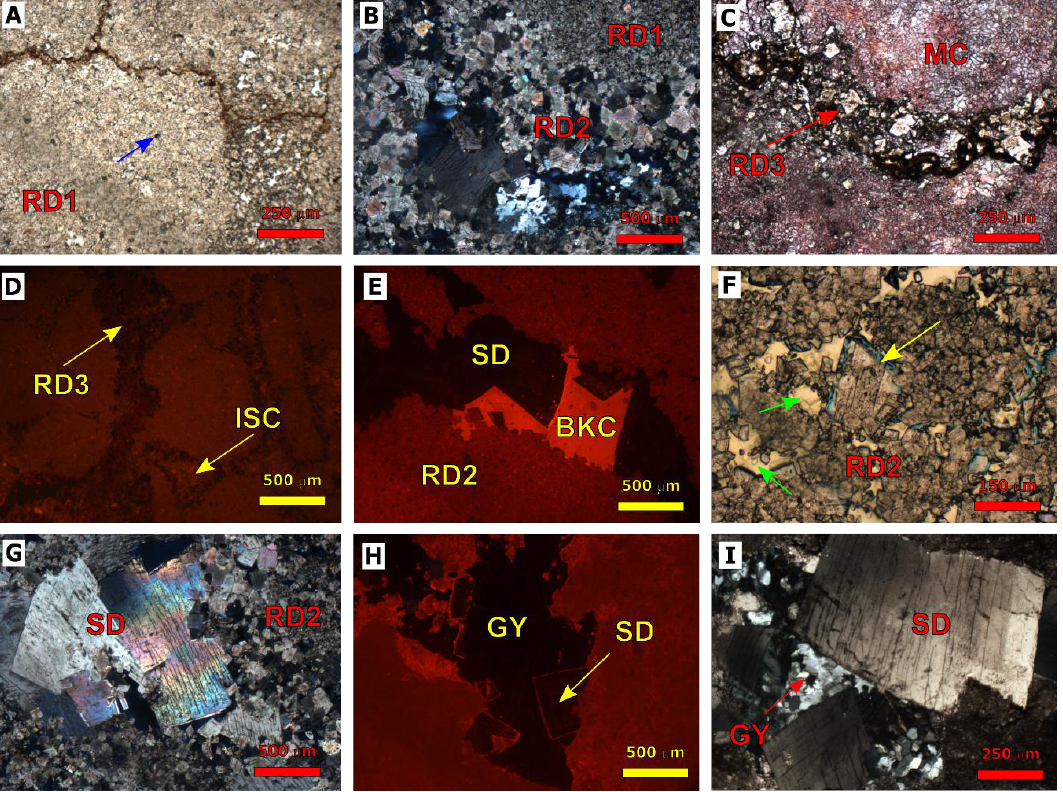
Figure 4. Dolomitization in Silurian formations. ( A ) Photomicrograph (PPL) of planar-s, pervasive replacive micro to fine crystalline dolomite matrix (RD1). Sample 1-18; Well: DGR1-CR65; depth: 176.13 m. The blue arrow indicates the presence of framboidal pyrite in the matrix; ( B ) photomicrograph (XPL) of non-planar, pervasive replacive micro to fine crystalline dolomite matrix and planar-e pervasive replacive medium crystalline dolomite matrix (RD2). Sample 1-31; Well: DGR1-CR133; depth: 440.92 m; ( C ) photomicrograph (PPL — after staining) of planar-e, selective replacive medium crystalline dolomite matrix (RD3) associated with dissolution seams showing cloudy cores and clear rims (red arrow). Undolomitized limestone matrix (MC) shows a pink color after staining. Sample 8-12; well: DGR8-CR137 (2); depth: 378.75 m; ( D ) CL photomicrograph of isopachous calcite cement (ISC) and selective replacive medium crystalline dolomite matrix (RD3) both showing dully-red luminescence. Note the change from dull to red luminescent of ISC towards the center of the vug. Sample 8-10; well: DGR8-CR122; depth: 332.26 m; ( E ) CL photomicrograph of bright luminescent blocky calcite cement (BKC) postdating non-luminescent saddle dolomite cement (SD) surrounded by dull-red medium crystalline dolomite matrix (RD2). Sample 8-13; Well: DGR8- CR139; Depth: 382.4 m; ( F ) photomicrograph (PPL — after staining) of planar-e to planar-s, pervasive replacive medium crystalline dolomite matrix (RD2) showing intercrystalline porosity (green arrows) and non-ferroan cores followed by later iron-rich rims (yellow arrow). Sample 1-24; well: DGR1- CR116 (2); depth: 328.17 m; ( G ) photomicrograph (XPL) of fracture filling saddle dolomite cement (SD) postdating pervasive replacive medium crystalline dolomite matrix (RD2) characterized by distinctive wavy extinction and curved crystal boundaries. Sample 1-31; Well: DGR1-CR133; Depth: 440.92 m. ( H ) CL photomicrograph of gypsum (GY) postdating non-luminescent with bright rims zoned saddle dolomite (SD). Sample 8-13; Well: DGR8-CR139; depth: 382.4 m; ( I ) photomicrograph